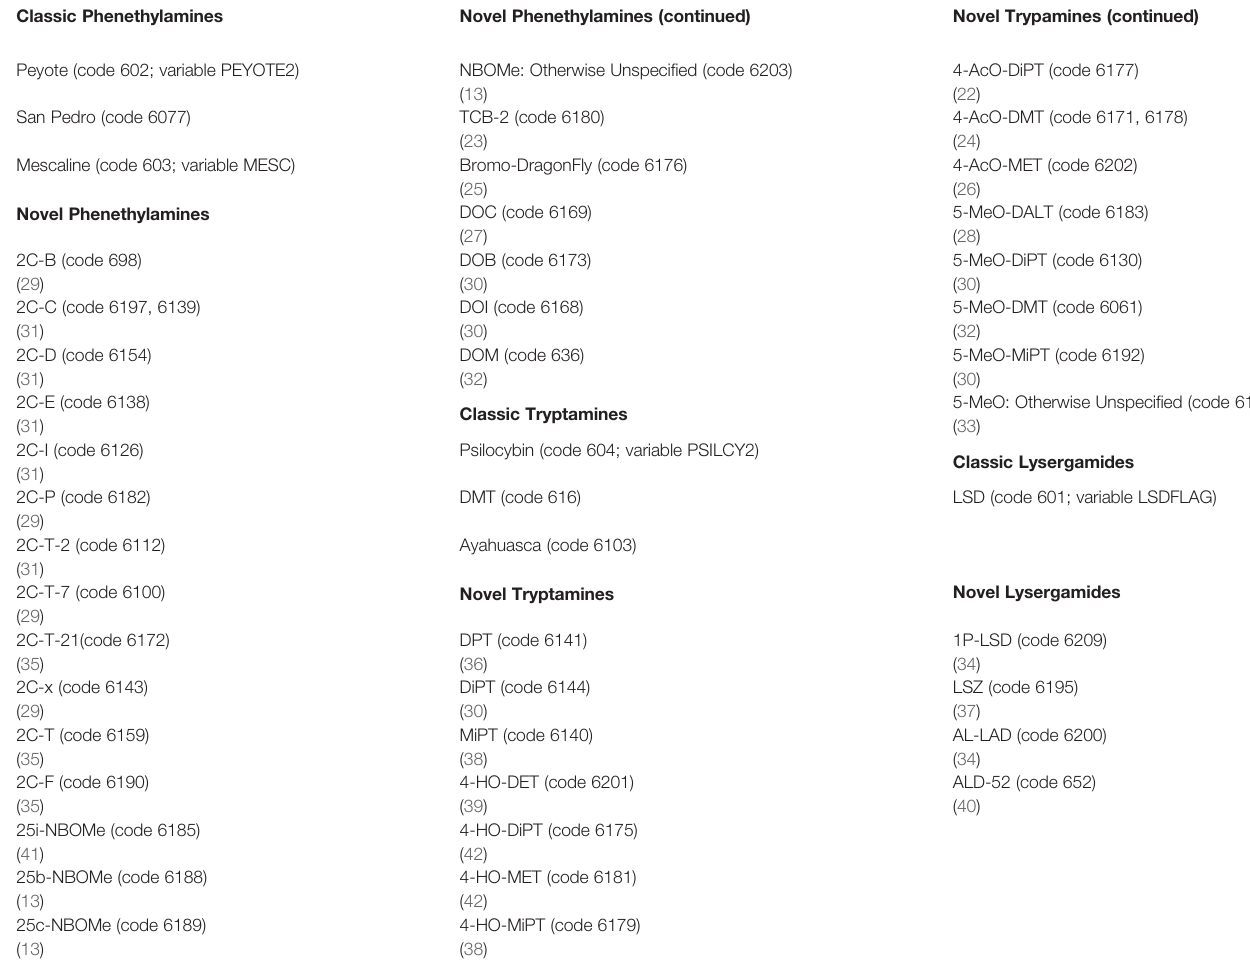
TABLE 1 | Psychedelic compounds reported by respondents from the 2008 – 2017 National Survey on Drug Use and Health (NSDUH), respective NSDUH codes, and citations to supporting